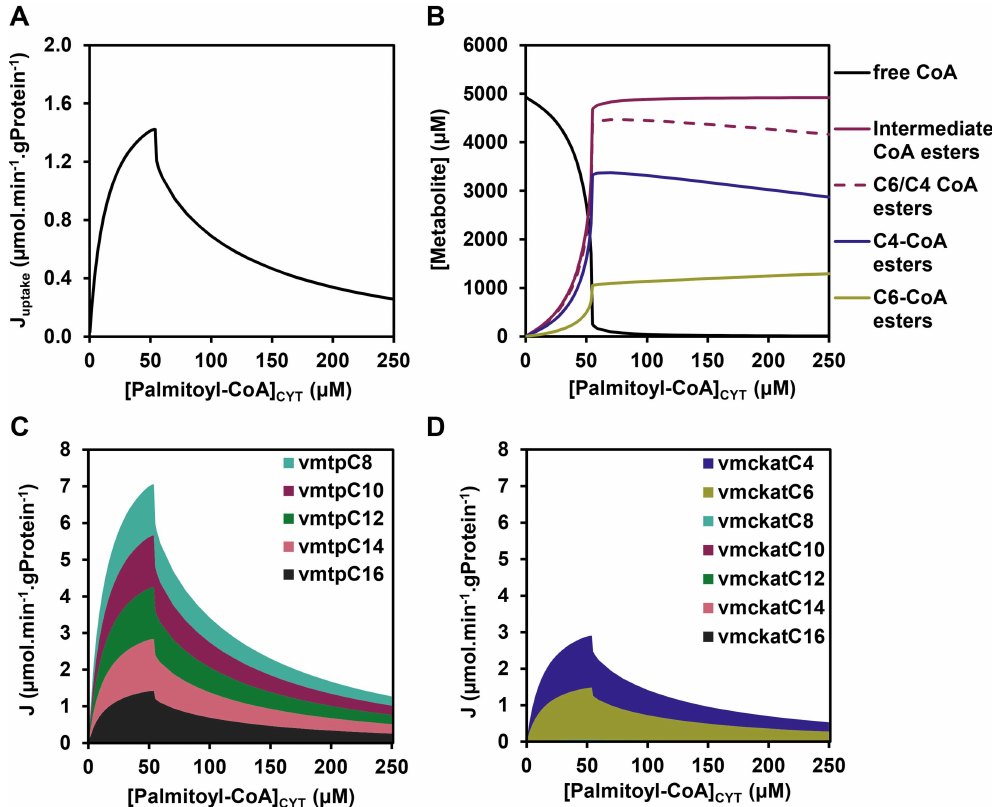
Fig 2. Simulated steady-state fluxes and concentrations in the mFAO model. (A) The effect of cytosolic palmitoyl-CoA concentration ([palmitoyl-CoA] CYT ) on the steady-state flux. The steady-state uptake flux of palmitoyl-CoA (J uptake ) is plotted (calculated as the steady-state flux of palmitoyl-carnitine through CACT, i.e. the uptake of palmitoyl-carnitineinto the mitochondria), in contrast to van Eunen et al . 2013 [8] in which the NADH flux was plotted. The two are uniquelylinked with the latter being 7-fold higher. (B) The steady-state concentrations of free CoA (identicalto data from [8]), the sum of all intermediate CoA esters, the sum of all C4- and C6 CoA esters and the subset of C4- and C6 CoA esters (new results). (C-D) Distributionof steady-state fluxes (J) of different chain-length substrates through MTP and MCKAT, respectively. Only the chain lengthswhich are convertedby these enzymes (cf. Fig 1) are